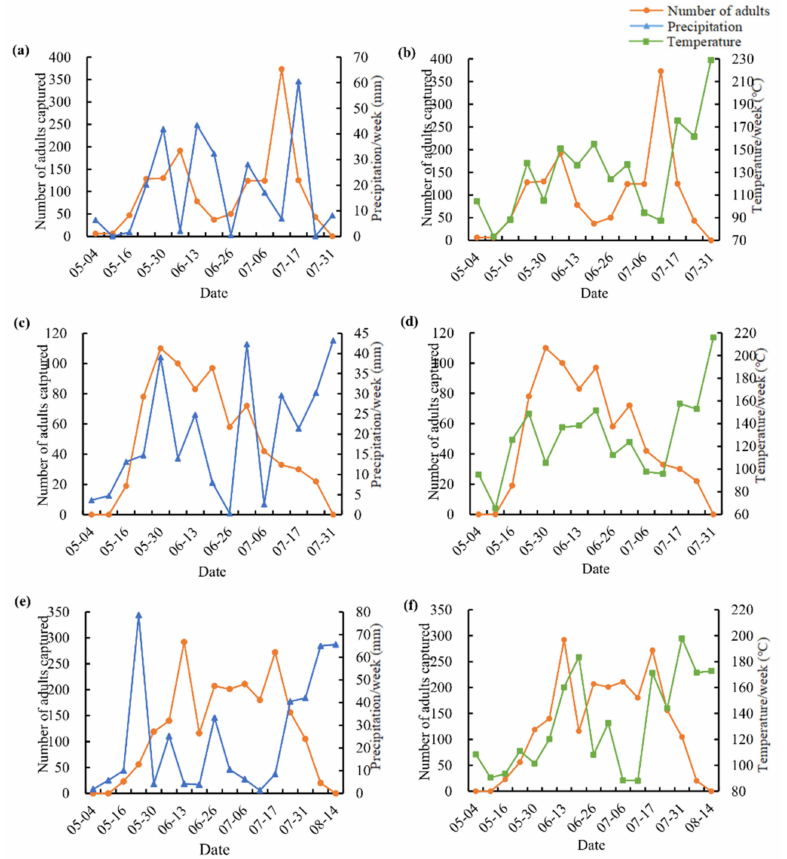
Figure 4. Relationship among the number of M. saltuarius adults captured per week, precipitation per week, and temperature per week. ( a , b ): in 2018, ( c , d ): in 2019, ( e , f ): in